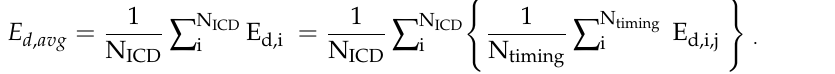
Figure 7. The change rate of deformed threshold displacement at 30 K. The graph shows the hydrostatic compression strain on ( a ) Ta ( c ) Ta – W and the hydrostatic tensile strain on ( b ) Ta ( d ) Ta-W.